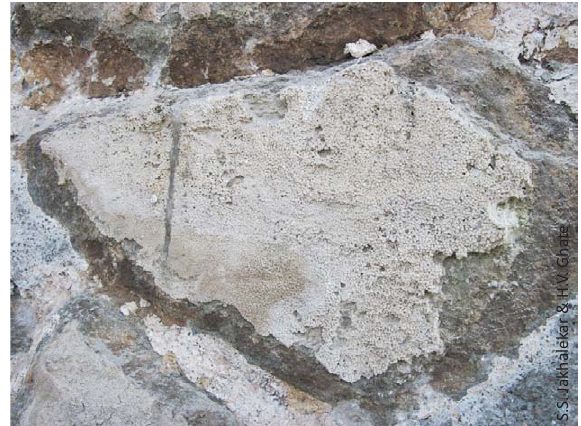
Image 14. Corvospongilla lapidosa habitus, off-white to grey stony hard